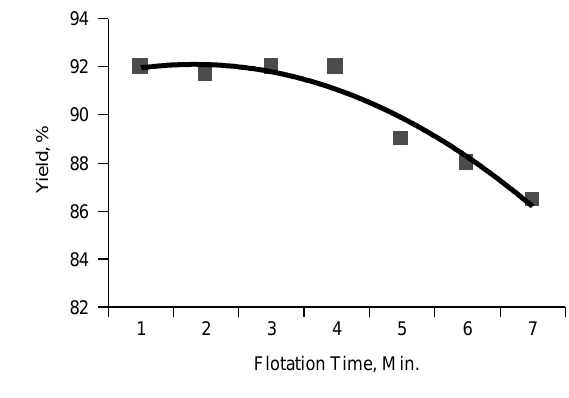
Fig. 3 Effect of flotation time on yield of de-inked pulp (0.5% H 2 O 2 , 0.1% NH 4 OH, 2 minutes